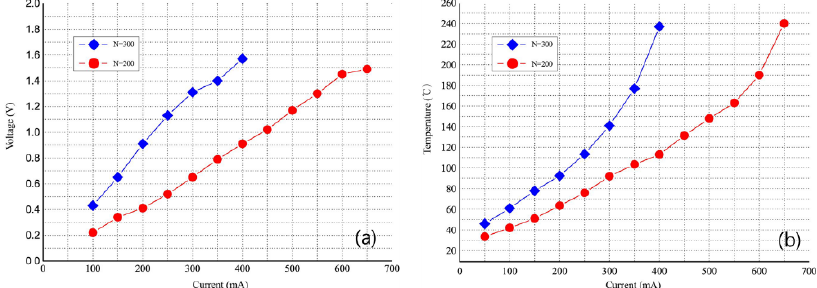
Figure 8. ( a ) Solenoid I-V characteristics and ( b ) temperature characteristics as a function of applied current, with different number of winding turns.